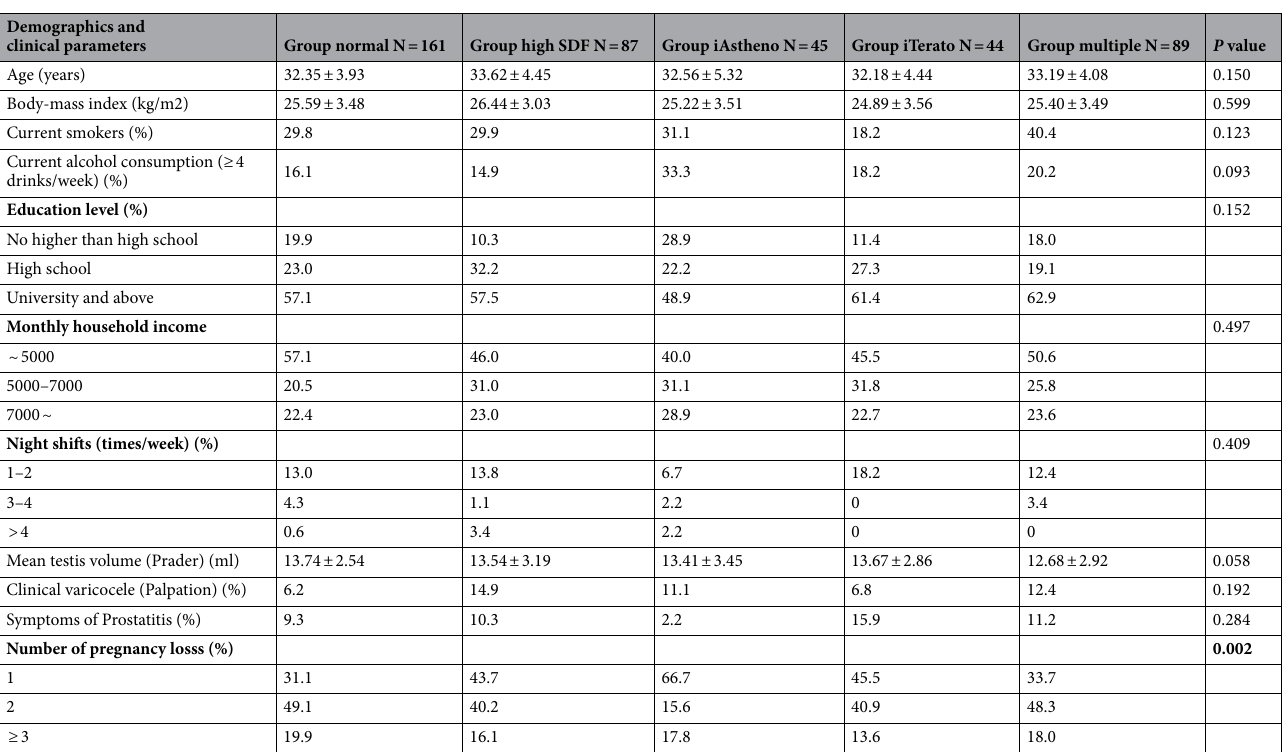
Table 1. Patient demographic characteristics and clinical information collected. Significant results are shown in bold ( p < 0.05, paired t test).Group normal: males with normozoospermia;Group high SDF:males with high sperm DNA fragmentation. Group iAstheno: males with isolated asthenozoospermia; Group iTerato: males with isolated teratozoospermia; Group multiple: males with multiple abnormalities of sperm.